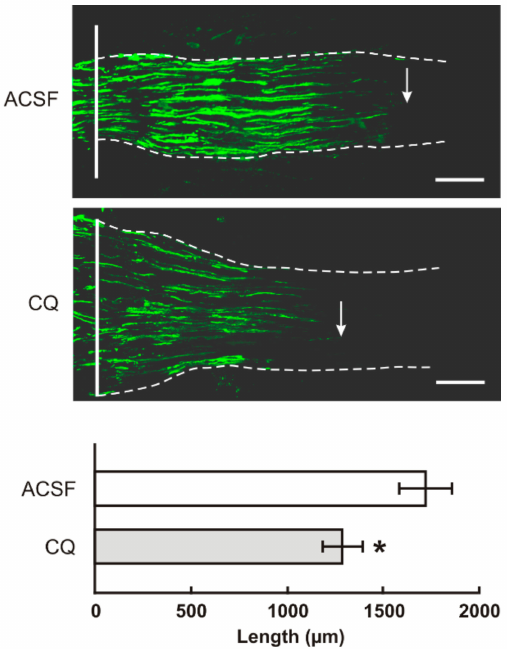
Figure 7. The top panels illustrate representative longitudinal sections through ulnar nerves distal to the crush site (solid line) showing SCG10 immunopositive regenerated axons. Arrows indicate the tip of the longest SCG10 immunopositive axons regenerated 1 day after the ulnar nerve crush in rats with prior CSNT for 7 days and intrathecal application of artificial cerebrospinal fluid (ACSF) or chloroquine (CQ). Scale bars = 280 µ m. The bottom panel illustrates mean length of regenerated SCG10 immunopositive axons ± SD in the ulnar nerve 1 day after crush and 7 days from intrathecal application of artificial cerebrospinal fluid (ACSF) or CQ; n = 6 for each group. * Significant difference ( p < 0.05) compared with ACSF in a Kruskal–Wallis ANOVA